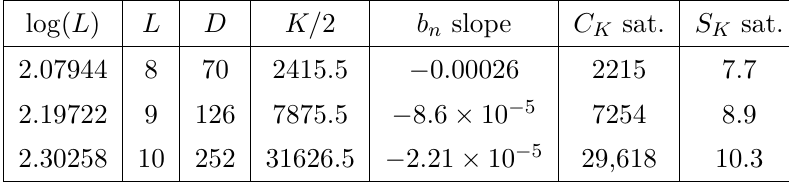
Table 1 . Summary table of the numerical phenomenology observed. Values averaged over several random realizations. In terms of S , log( L ) ∼ log( S ) , L ∼ S, D ∼ e S and K ∼ e 2 S